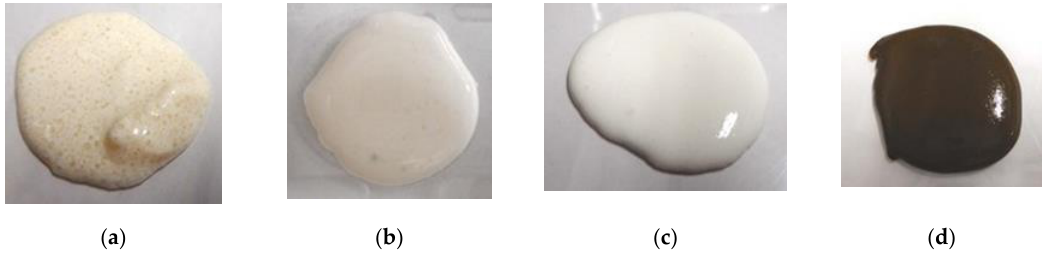
Figure 2. Images of liquid before electrolytic polymerization; ( a ) KF96 (1000 cSt) + NR-latex without PVA; ( b ) KF96 (1000 cSt) + NR-latex (Ulacol) with PVA; ( c ) KE1400 + CR-latex (671A) with PVA; ( d ) KE1400 + CR-latex (671A) + MCF with PVA.